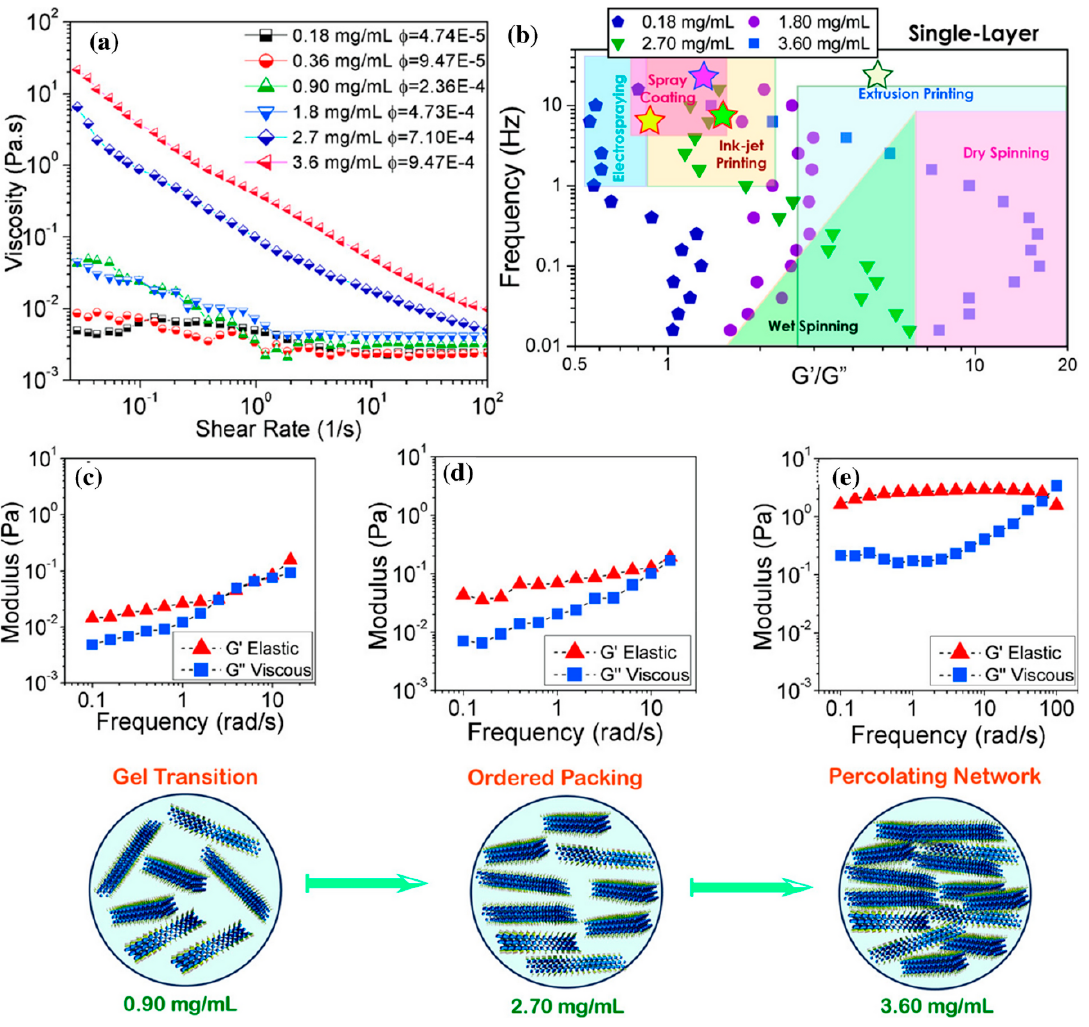
Figure 4. Viscoelastic response of 0.18–3.60 mg mL − 1 (volume fraction, ϕ , 4.74 × 10 –5 –9.47 × 10 –4 ) mono-layer Ti 3 C 2 T x MXene in water. ( a ) Shear rate against viscosity ( b ) Frequency verses G ′ /G ′′ in different fabrication techniques. The stars show the approximate parameters used in MXene appli- cations obtained from the literature. The viscoelastic behavior of MXene suspensions having ( c ) 0.9 mg mL − 1 , ( d ) 2.7 mg mL − 1 , and ( e ) 3.6 mg mL − 1 MXene loadings under 0.1% strain amplitude, re- printed with permission from [87] .